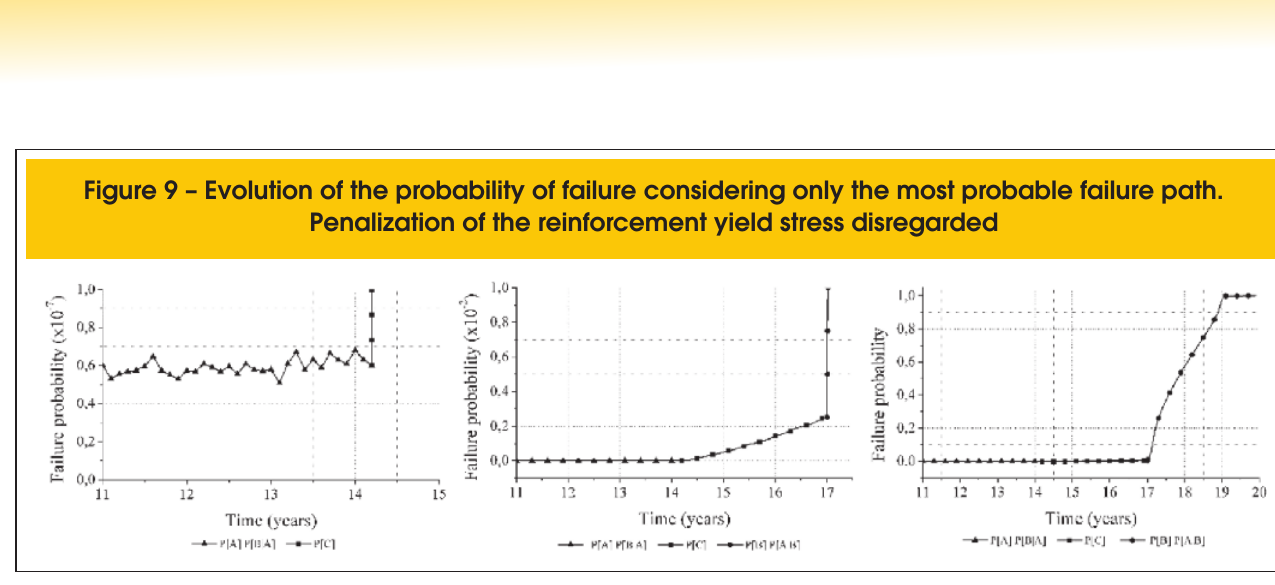
Figure 8, sudden brittle failures due to shear effort may appear before the expected ductile bending failures.